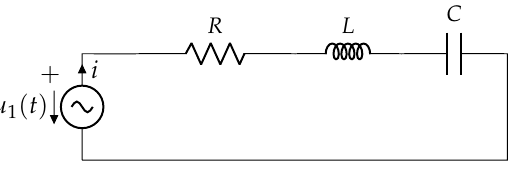
Figure 2. RLC circuit used in Example